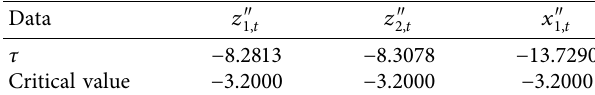
Table 5: Data stationary test z